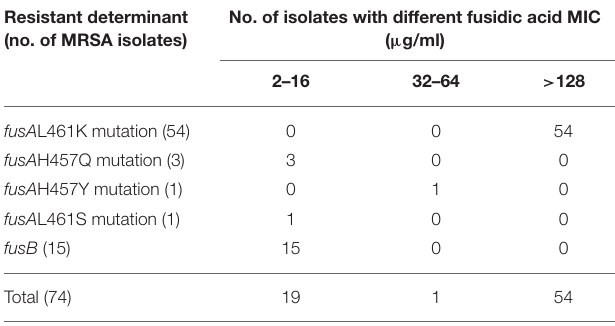
TABLE 2 | Distribution of fusidic acid MIC to resistant determinants among FA-resistant MRSA isolates. Resistant determinant No. of isolates with different fusidic acid MIC (no. of MRSA isolates) ( µ